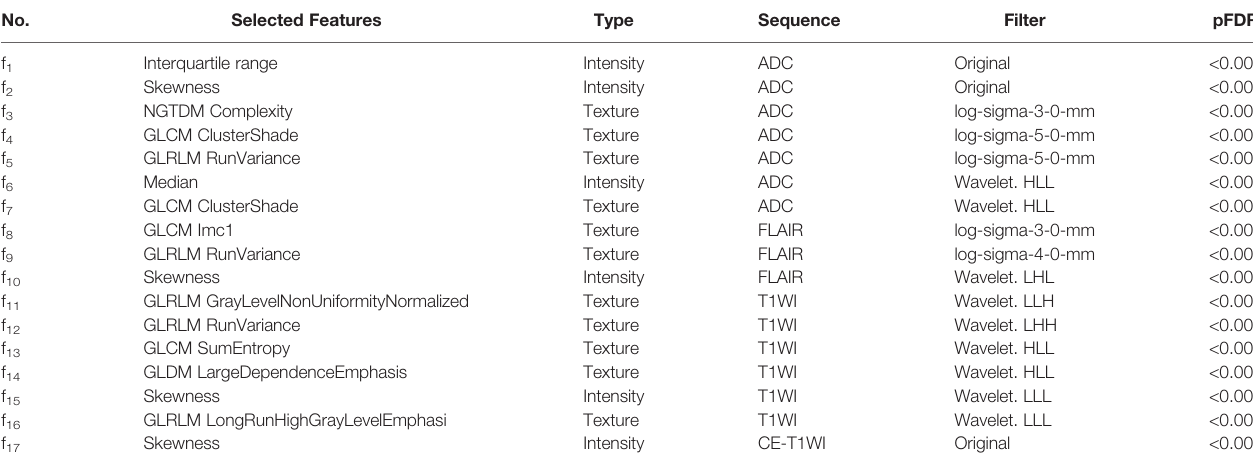
TABLE 2 | Selected radiomics features for predicting the molecular subtypes of lower-grade glioma patients.